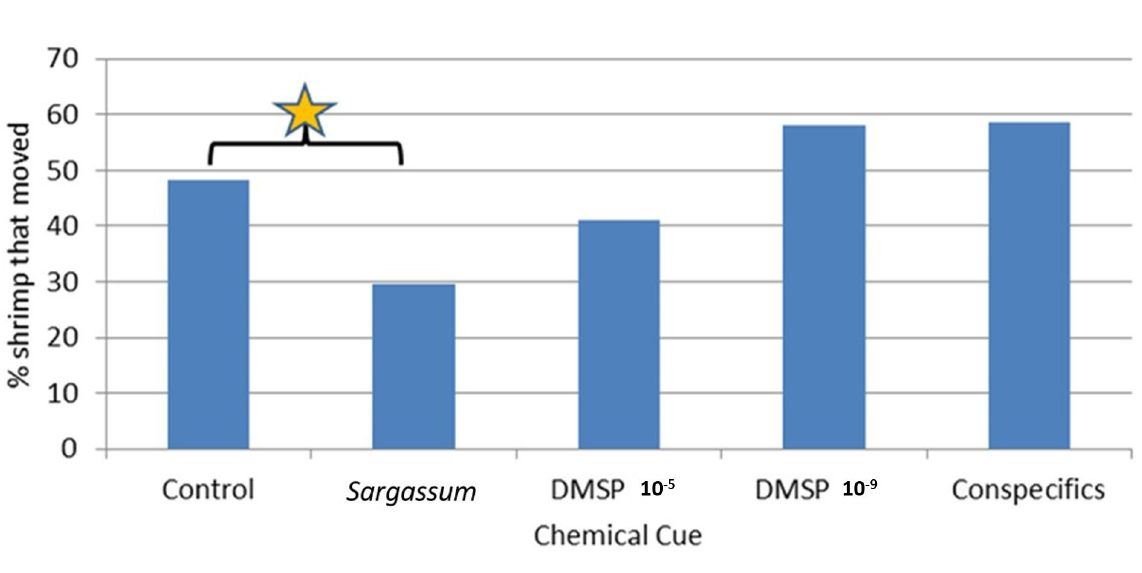
Figure 6. Number of Latreutes fucorum male shrimp that moved out of area C in the Y-maze for the control, Sargassum , DMSP 10 − 5 M, DMSP 10 − 9 M, and conspecific cue trials (binomial test; Sargassum p = 0.01; DMSP 10 − 5 M p = 0.10; DMSP 10 − 9 M p = 0.08; and conspecifics, p = 0.08). Star/bracket indicates significant differences between indicated paired